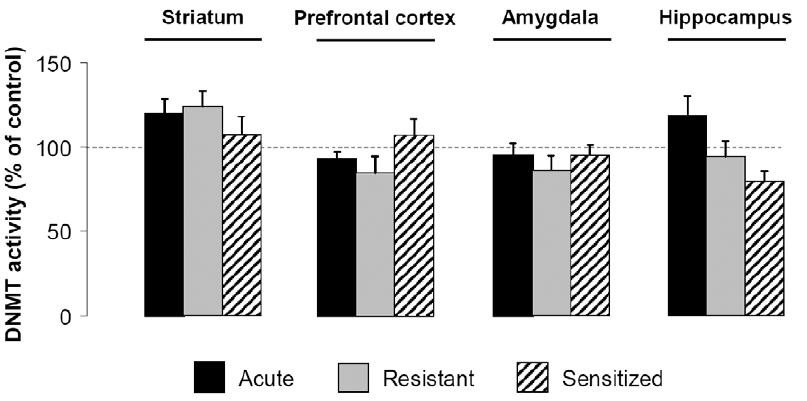
Figure 5. Expression of EIBS is not due to changes in global DNMT activity. During 10 days, mice received daily i.p. injections of saline or ethanol (2 g/kg) solution. DNMT activity was measured in nuclear fractions of striatum, prefrontal cortex, amygdala and hippocampus 30 min after